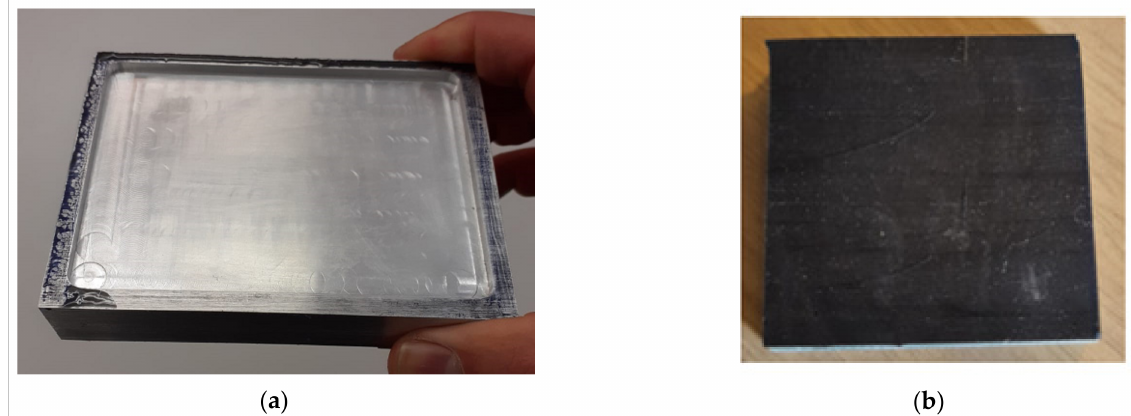
Figure 5. ( a ) Aluminum mold for casting thin coating film; ( b ) A finished rain erosion specimen with PU + GNP top